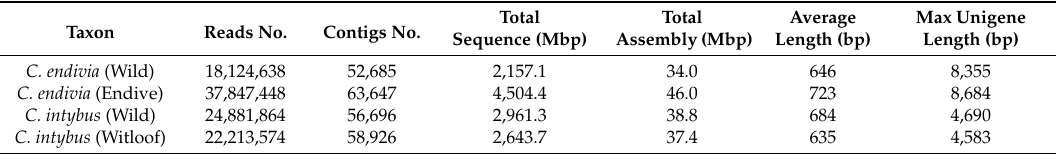
Assembly statistics for transcriptomes of four accessions from the Cichorium